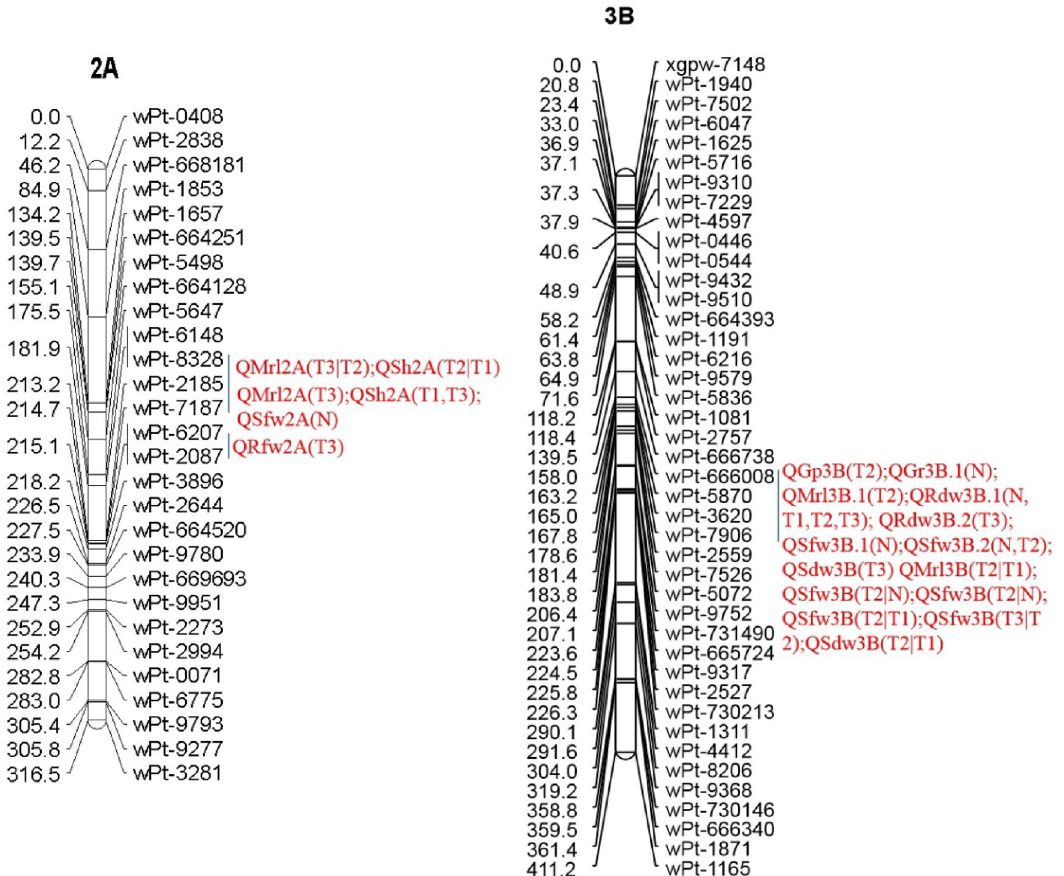
Figure 1. QTL clusters on the genetic map including unconditional and conditional QTLs under salt stress at different